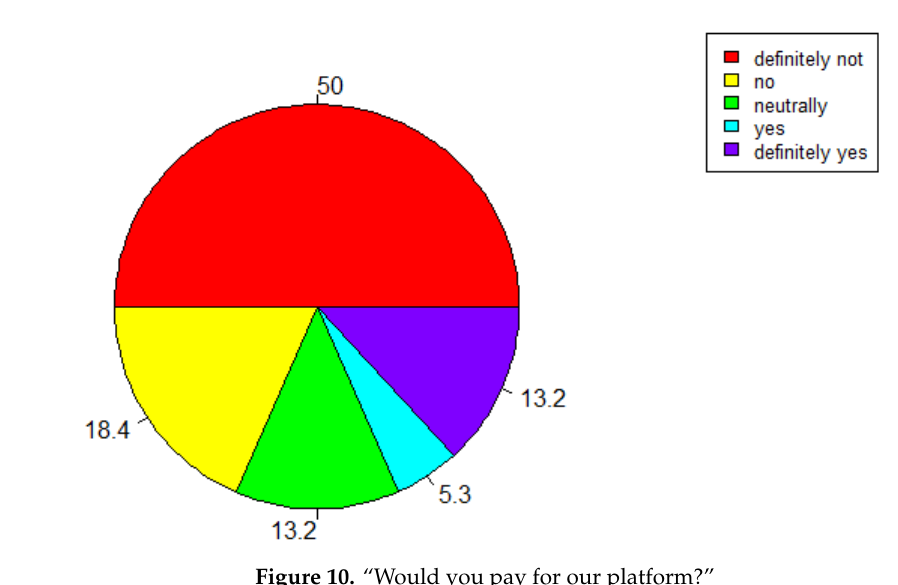
Figure 10. “Would you pay for our platform?”